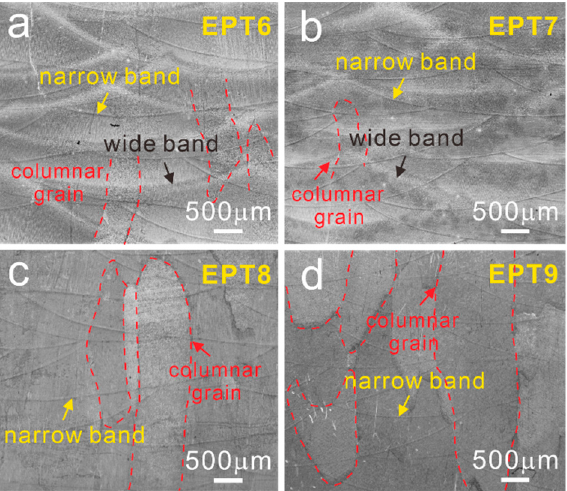
Figure 4. OM images of the wide bands and narrow bands in TC11 samples after being treated with different EPT voltages: ( a ) EPT6; ( b ) EPT7; ( c ) EPT8; ( d ) EPT9.